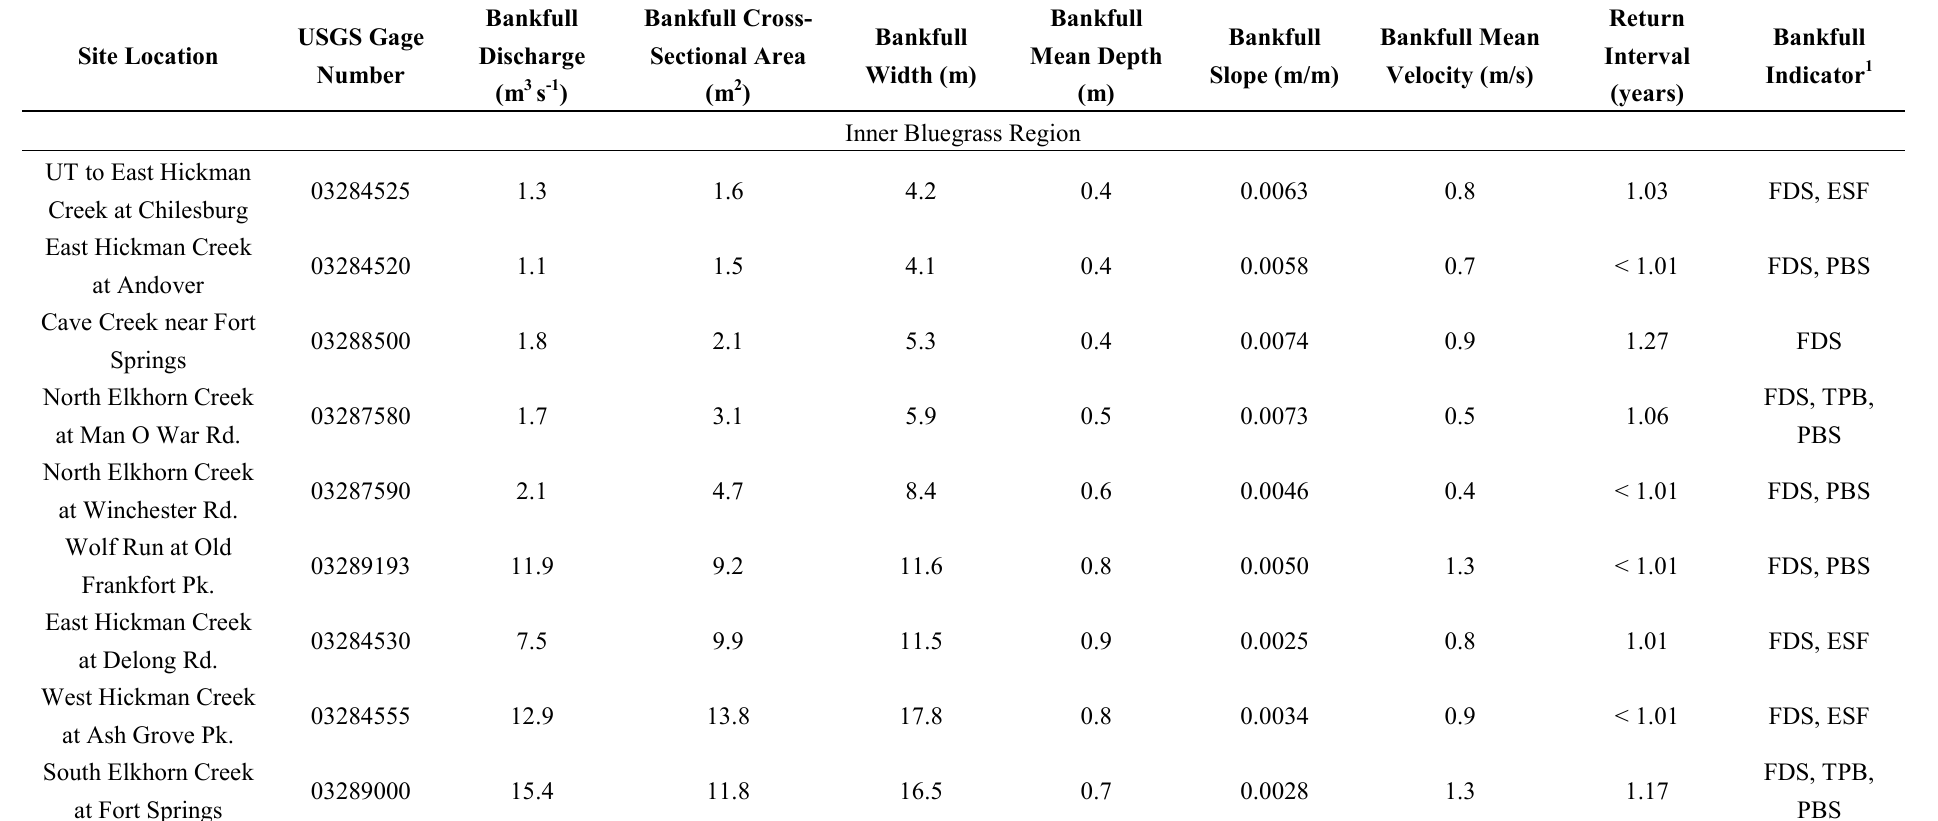
Table 1. Bankfull summary data for the selected sites in the Inner Bluegrass and Outer Bluegrass regions. Adapted from Brockman et al . [42]. Used by permission from